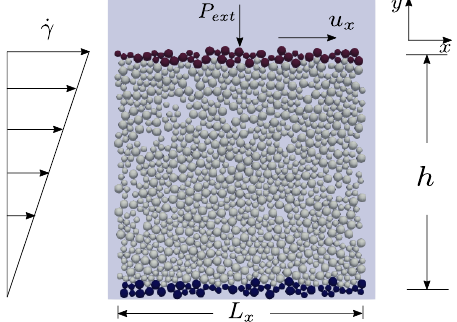
Figure 2. Steady state rheology. µ SS (left) and φ SS (right) as a function of J . In dashed lines, fits to the functions indicated in the respective plots. These fits are also shown as µ SS − µ c and φ c − φ SS versus J in the respective